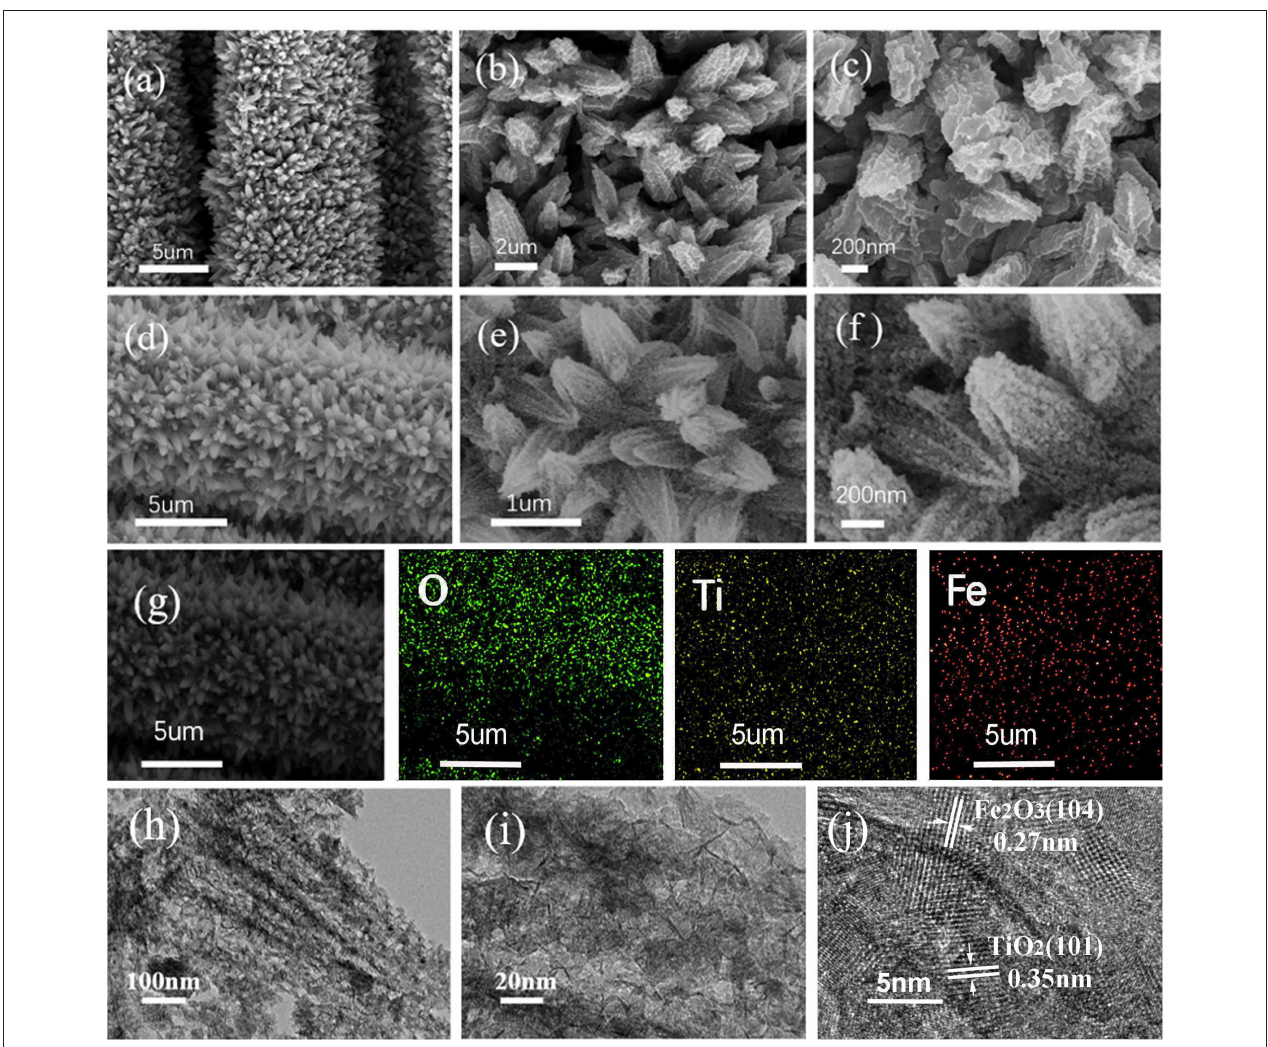
FIGURE 2 | SEM images of the prepared specimens at different magnifications. (a–c) CC/TiO 2 specimens. (d–f) CC/TiO 2 /Fe 2 O 3 specimens. (g) EDX elemental mapping of the CC/TiO 2 /Fe 2 O 3 specimens. (h–j) TEM and HRTEM images of CC/TiO 2 /Fe 2 O 3